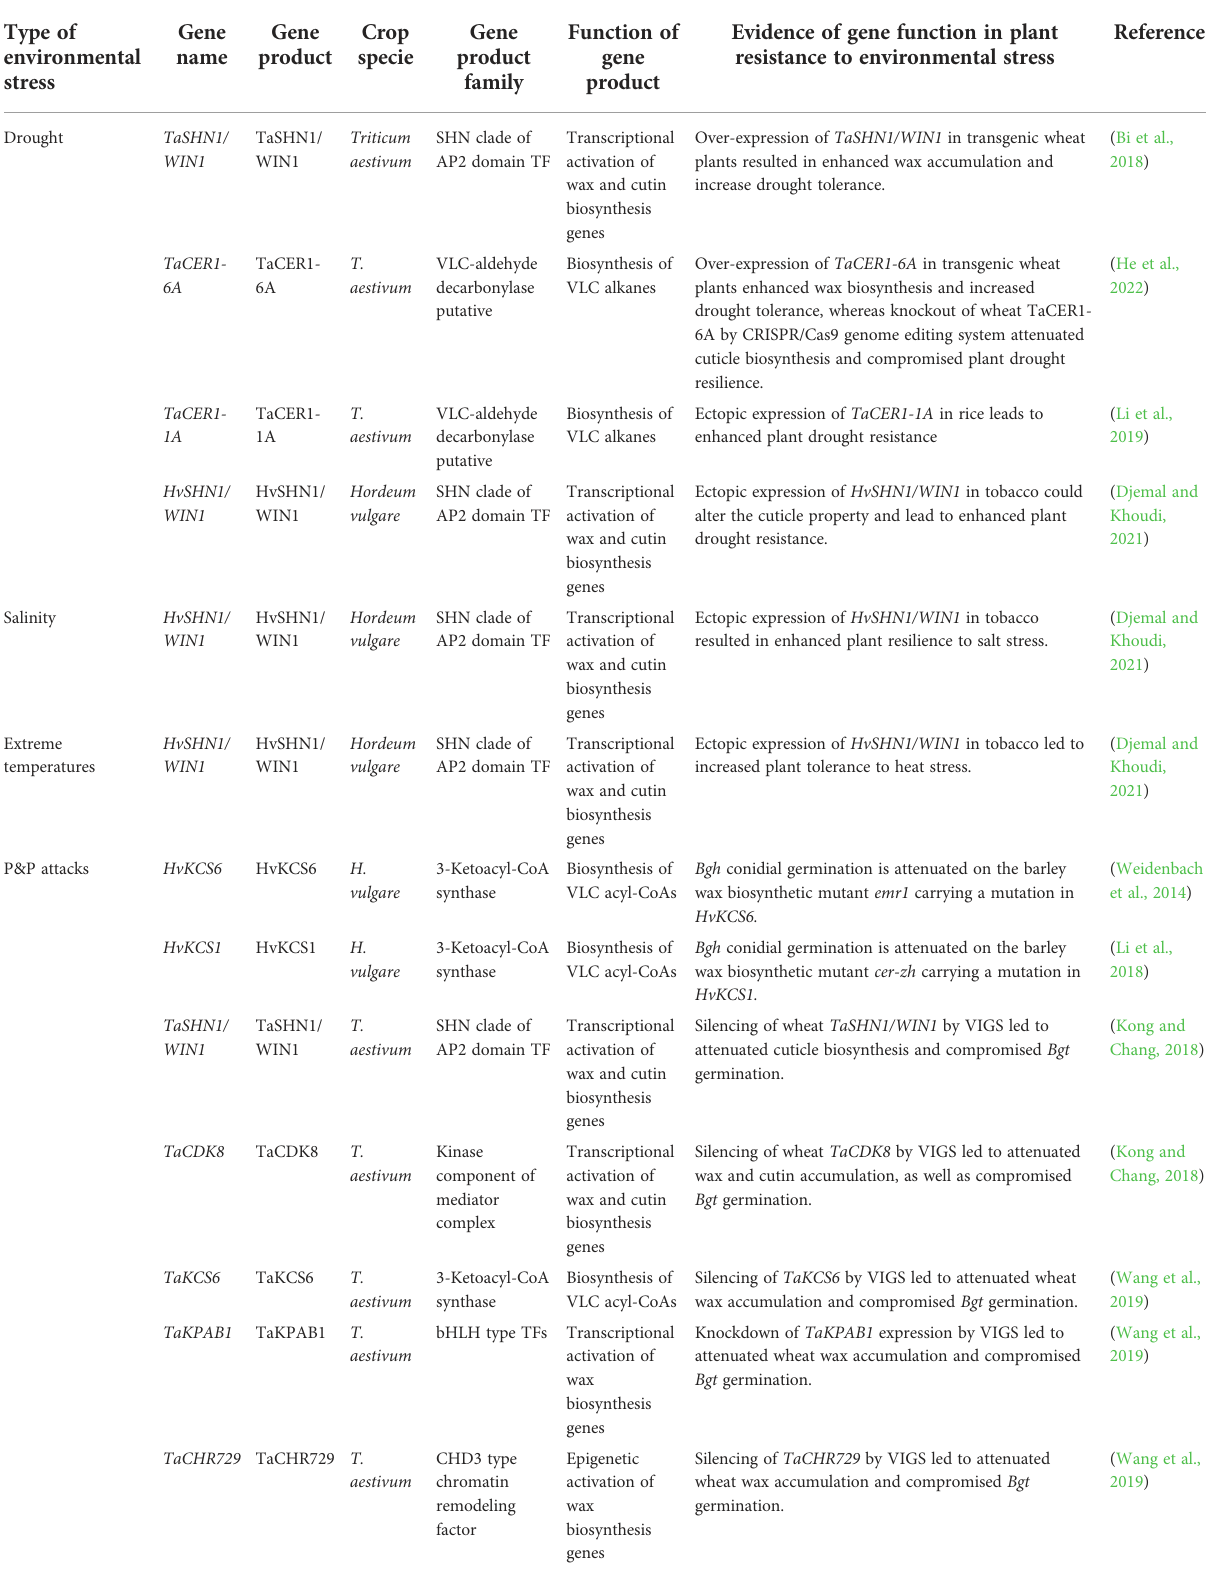
TABLE 1 Summary of cuticle biosynthesis genes contributing to abiotic and biotic stress tolerance in wheat and